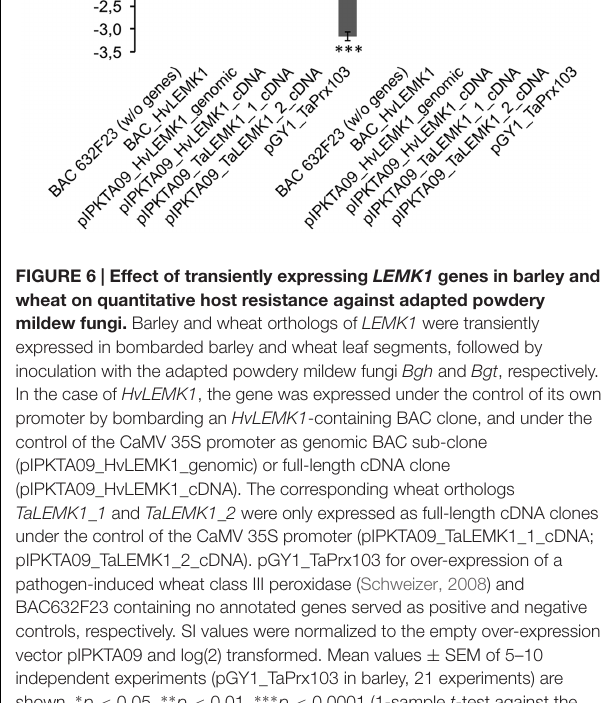
strong PTI responses are activated by PAMP-recognizing PRRs for the inhibition of which the non-adapted pathogen had lost functional effectors (Schulze-Lefert and Panstruga, 2011).